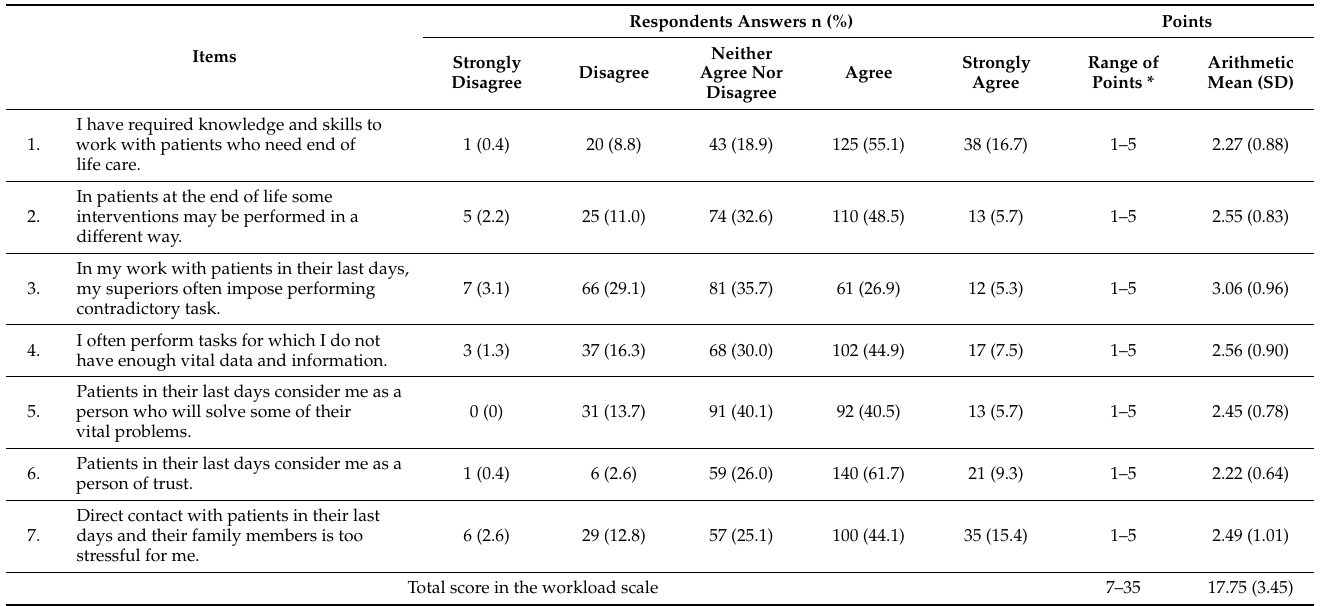
Table 4. Nurses’ level of workload when providing EoLC-distribution of respondents’ answers (n = 279).